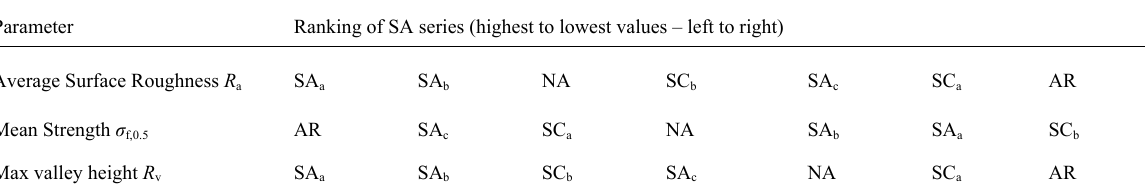
Table 5: Evaluation of the artificially aged series for roughness and strength (highest to lowest values) Parameter Ranking of SA series (highest to lowest values – left to right) Average Surface Roughness R a SA a Mean Strength σ